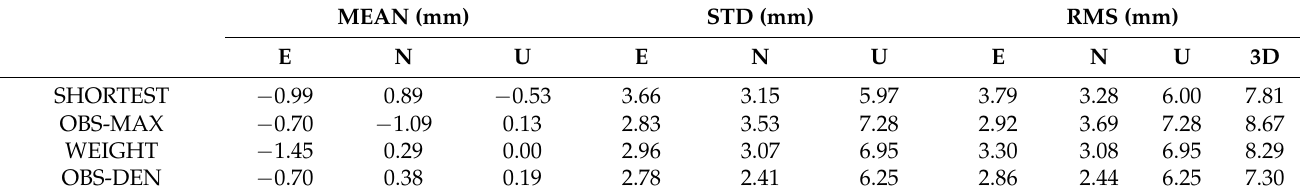
Table 1. Accuracy comparison of single-day solutions of different methods. The statistics of station accuracies are calculated in the local coordinate system. The three axes of the local coordinate frame are East (E), North (N), and Up (U). The left, middle and right columns show the mean, the standard deviation (STD), and the root mean square (RMS) of the station coordinate errors of each method,